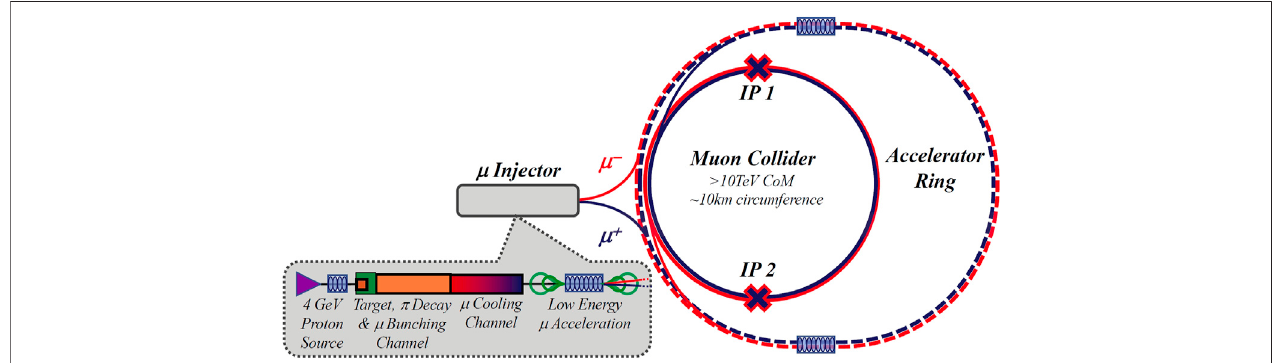
FIGURE 2 | A conceptual scheme for the muon collider